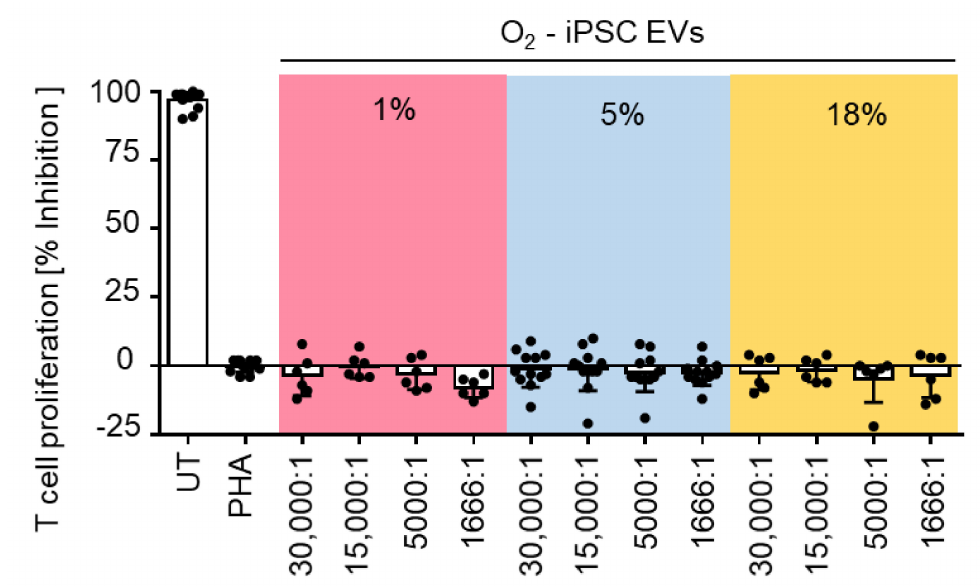
Figure A3. No inhibition of T cell proliferation by iPSC EV generated from human iPSCs at. Mitogenesis of T cells was induced by adding phytohemagglutinin (PHA) and compared to the proliferation of untreated (UT) T cells. Human iPSC- EVs that were generated in iPSC cultures at different oxygen levels and analyzed in triplicates per experiment (iPSC-EVs